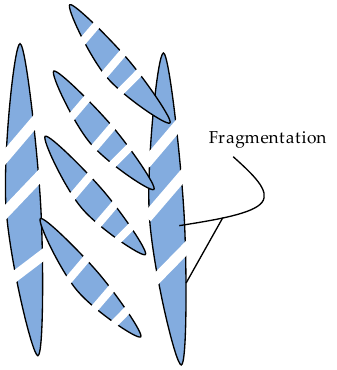
Figure 8. Schematic of morphology transformation during annealing in the high-SSTR.